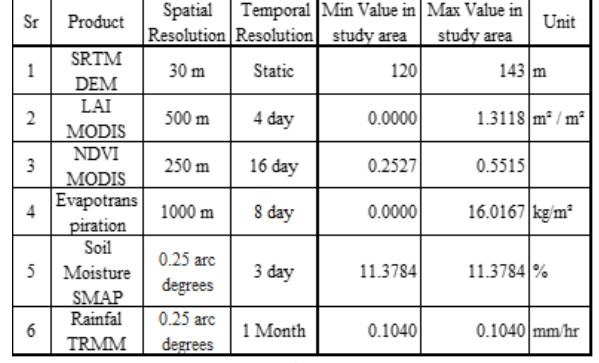
Table 1. List of input datasets